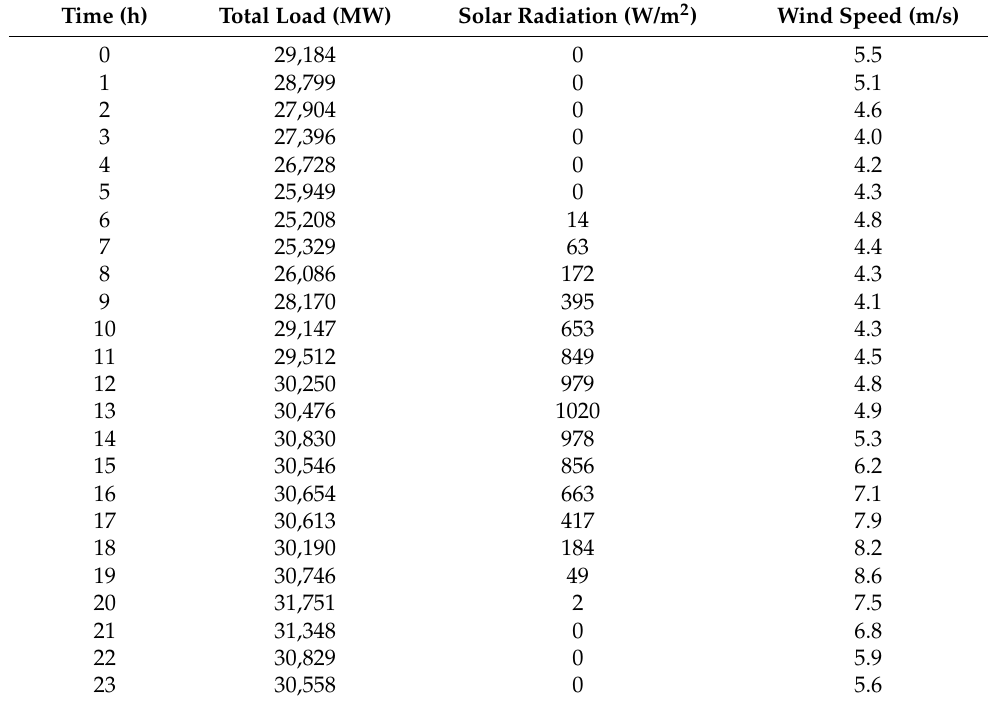
Table 1. Summer daily load, solar radiation and wind speed in Egypt. Time (h) Total Load (MW)